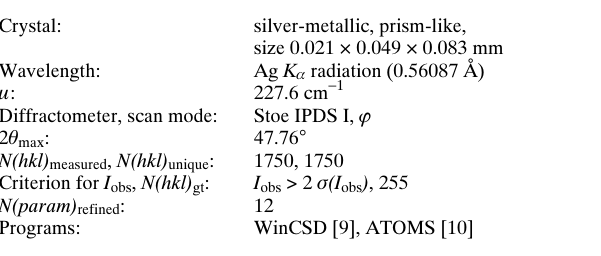
Table 1. Data collection and handling.